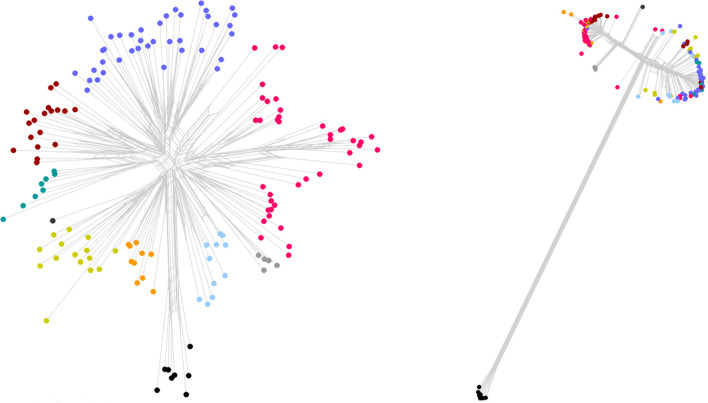
Comparison of NeighborNet representations of the presence or absence of accessory genome components as determined by PanSeq analysis (left) with clusters coloured, and the same clusters projected on the observed SNP variation among the same isolates (right) using the same colour coding.